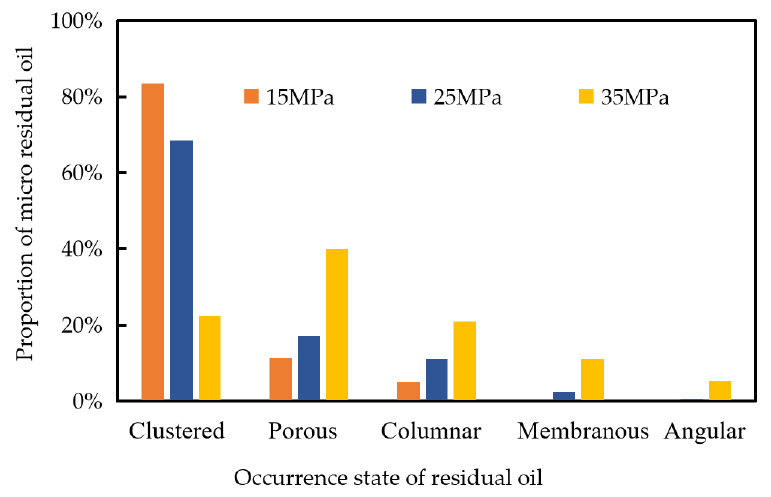
Figure 13. Percentage of the micro remaining oil occurrence state under different pressures after huff and puff.